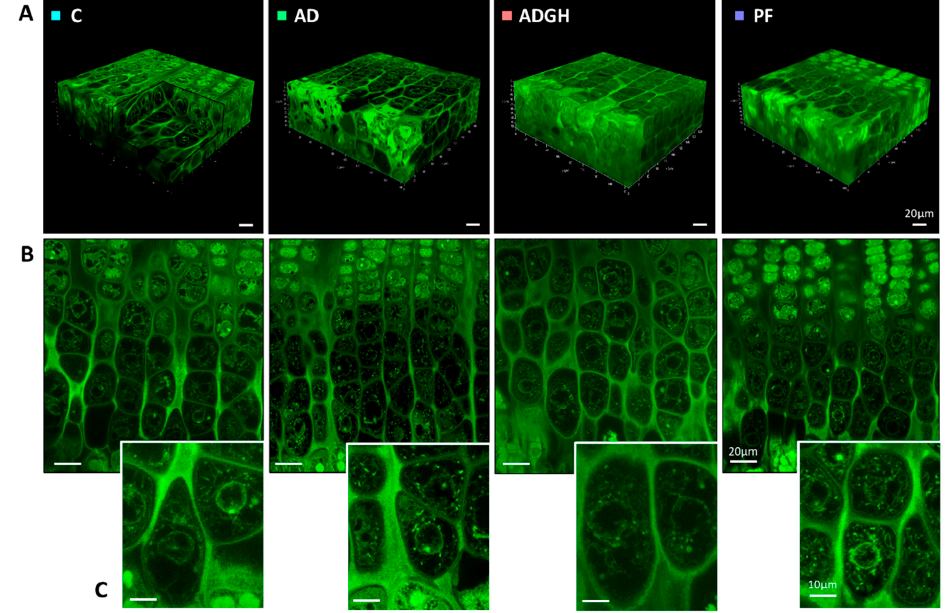
Figure 1. Confocal imaging of the growth plate cartilage. ( A ) A 3D projection of the thick section of the growth plate columns. Three-dimensional visualization is shown in Supplementary Videos 1–8. ( B ) Optical sections of focal planes of the hypertrophic zone. ( C ) Detail of terminal hypertrophic chondrocytes of the growth plates of the four experimental groups. C, control rats; AD, adenine 0.5% rats; ADGH, adenine 0.5% rats treated with growth hormone; PF, pair-fed rats. * p value < 0.05.